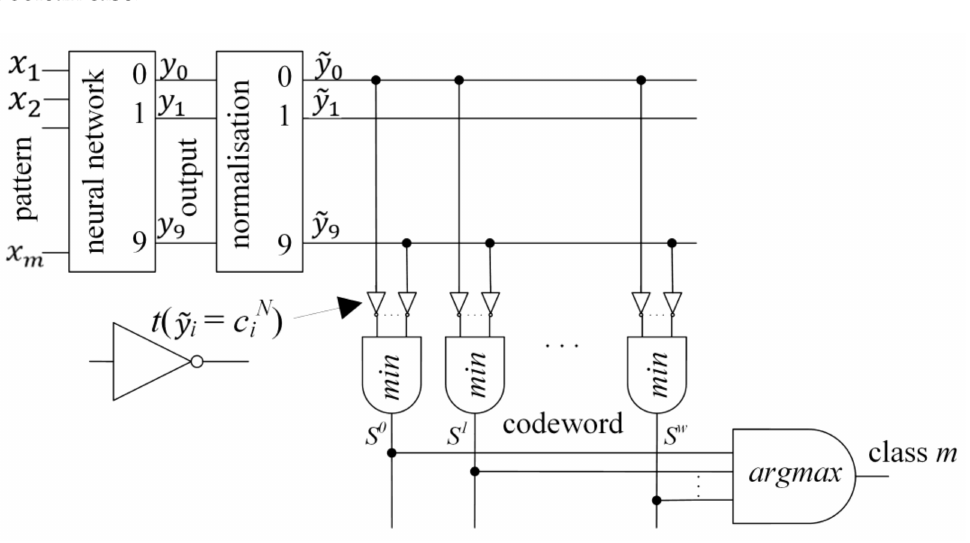
Figure 1. Proposed classification scheme based on the Zadeh fuzzy logic. The demand for processing analog channel outputs by digital coding is not new